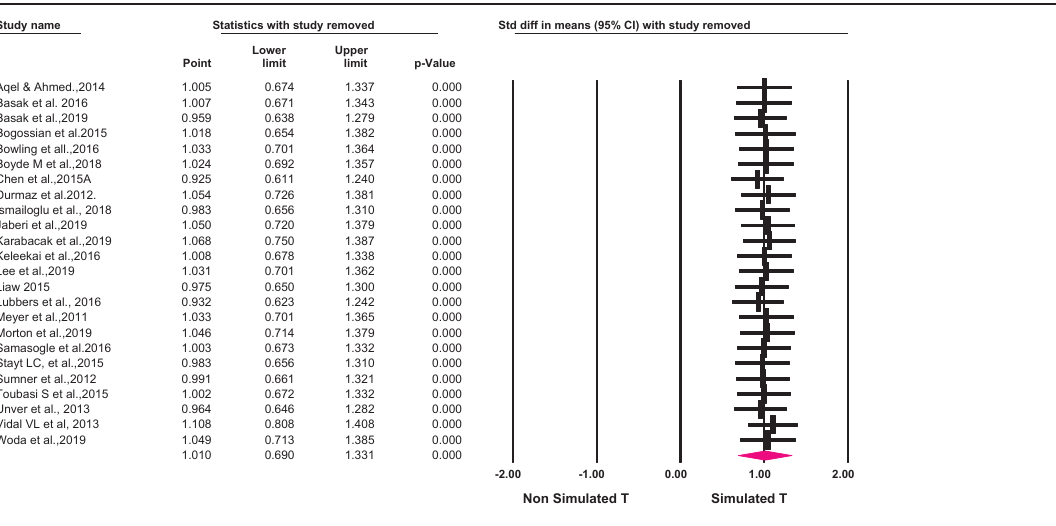
Figure 2. Forest plot showing the effect size of individual studies.